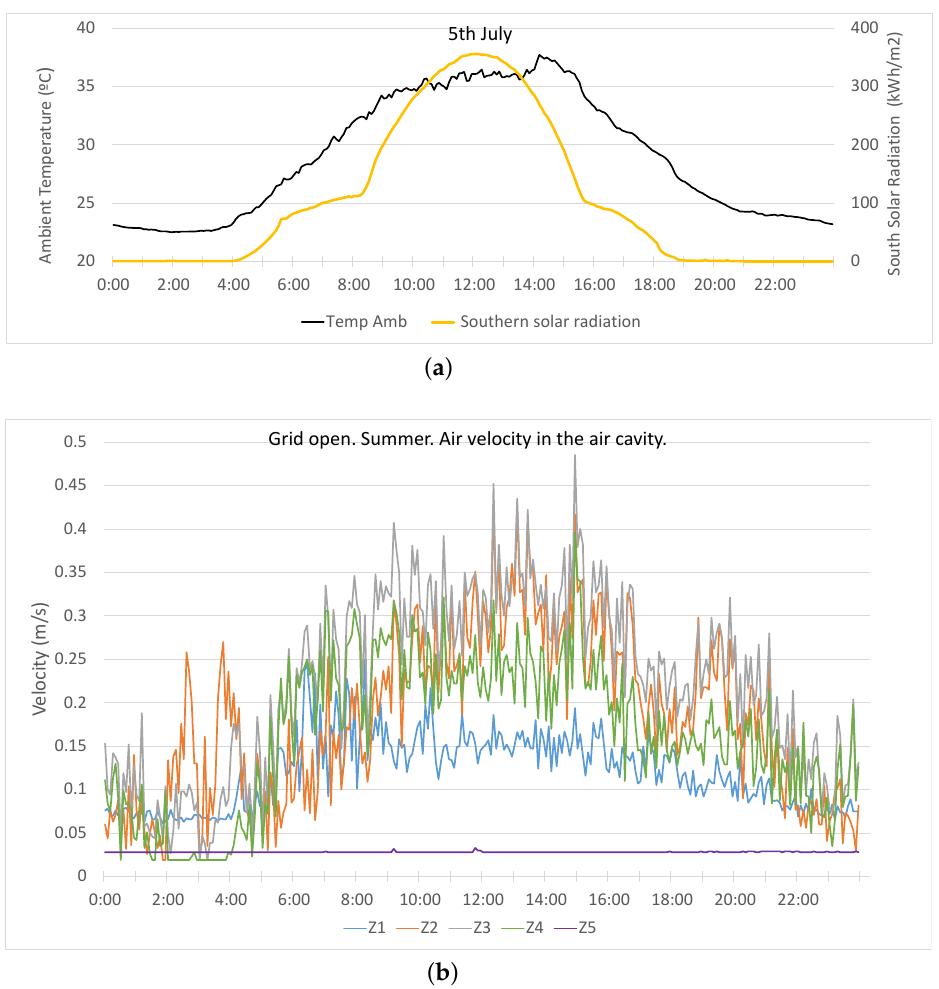
Figure 9. Open ventilation grills, 5 July 2021: ( a ) south solar radiation and ambient temperatures; ( b ) trend of the measured air cavity velocities at the ventilated